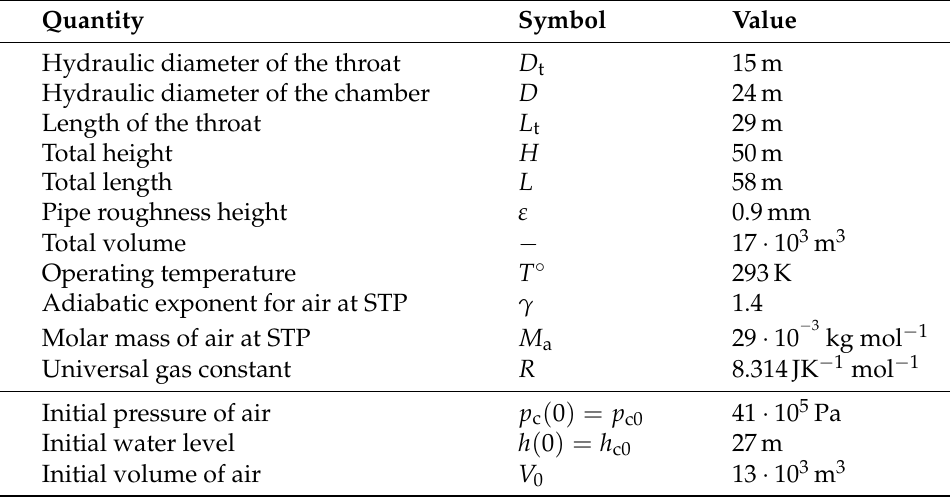
Table 1. Parameters and operating conditions of the ACST for Torpa